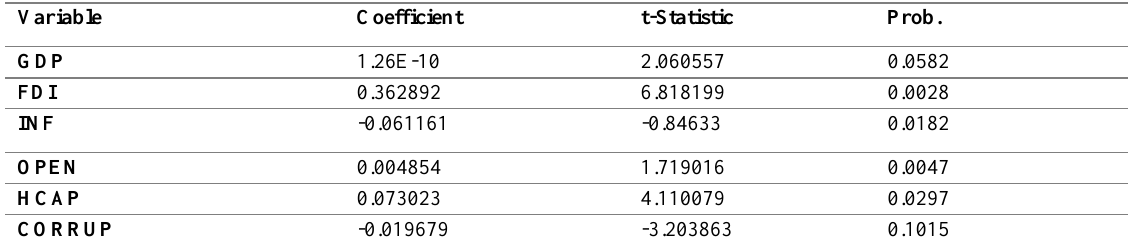
Table 5: Panel Group FMOLS